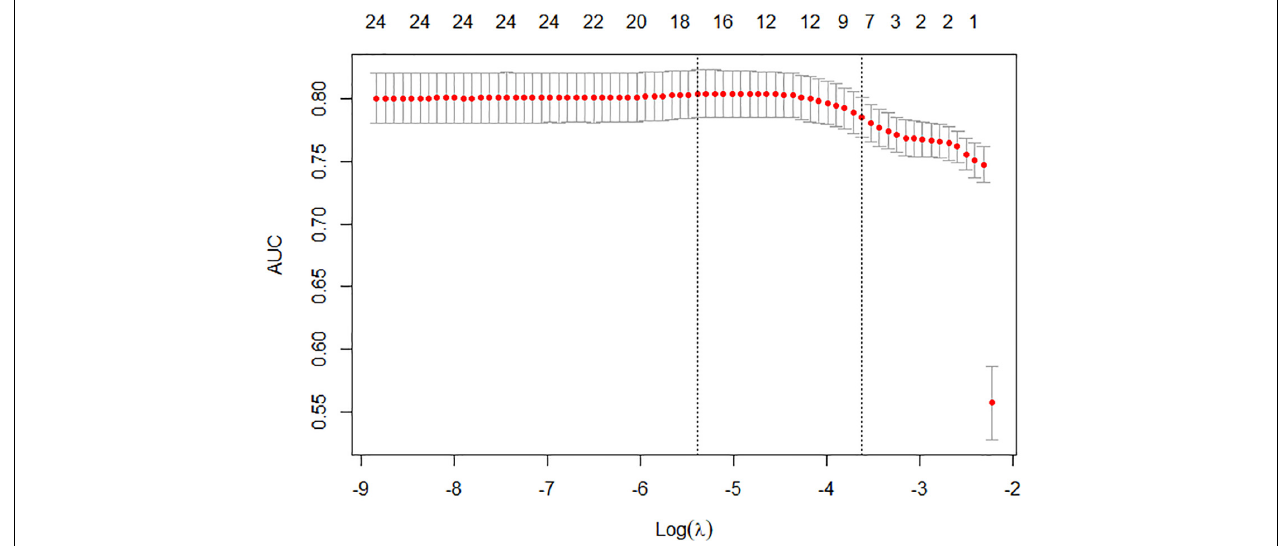
FIGURE 3 | The ROC curve of the preliminary screened variables in the training set and the test set. ROC, receiver operating curve.